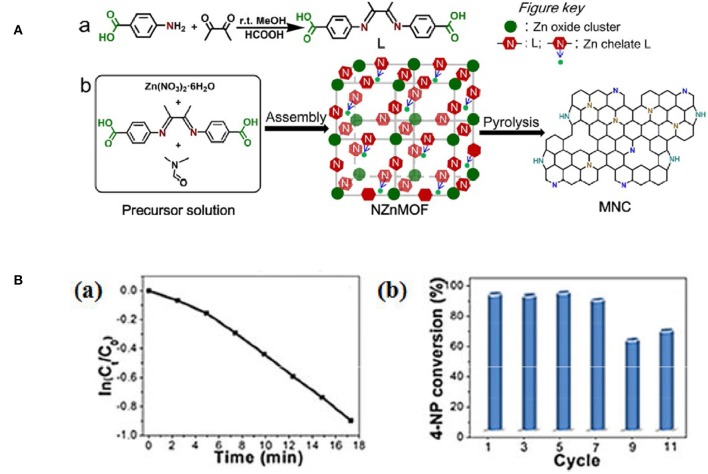
(A) Schematic illustration of (a) the synthesis of 1,4-bis(4-C02HC6H4)- 2,3-dimethyl-1,4-diazabutadiene (L) and (b) the synthesis of mesoporous N doped carbons through pyrolysis of N-rich MOF precursors. From Yang T. et al. (2015) with permission from Wiley. (B,a) The relationship between ln(Ct Co) and reaction time (t), and (b) catalytic conversion of 4-NP at different cycles. From Yang T. et al. (2015) with permission from Wiley.